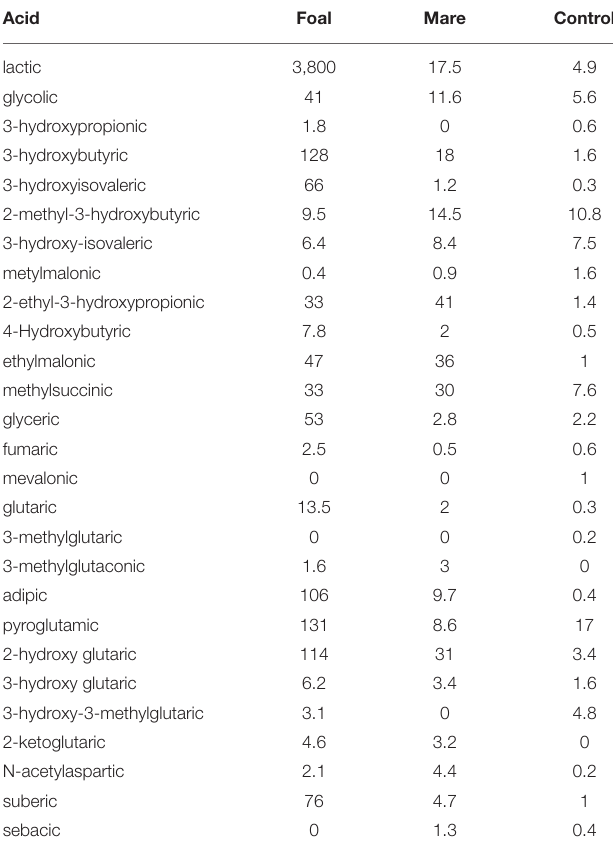
TABLE 4 | Excretion of organic acids in urine showing organaciduria which is severe in the foal, less pronounced in the mare, values in mg/g creatinine.